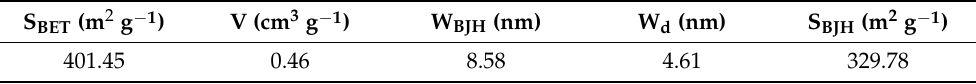
Table 2. Pore structure parameters of diatom